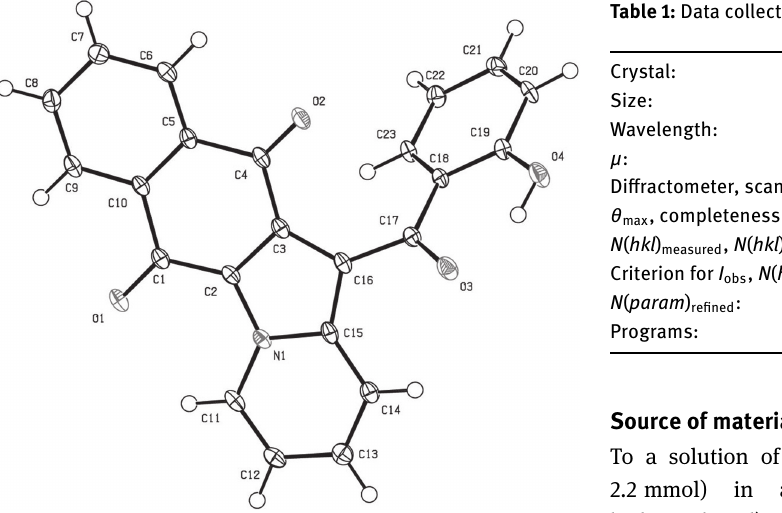
Table 1: Data collection and